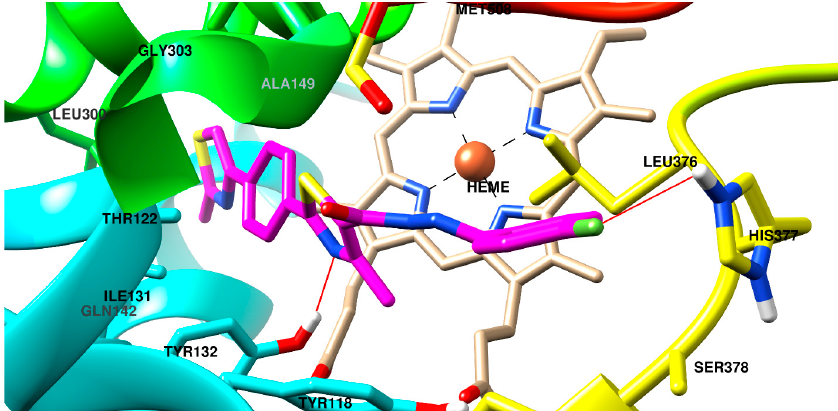
Figure 2. Docking pose of the compound 5d in the binding site of lanosterol 14 α -demethylase.